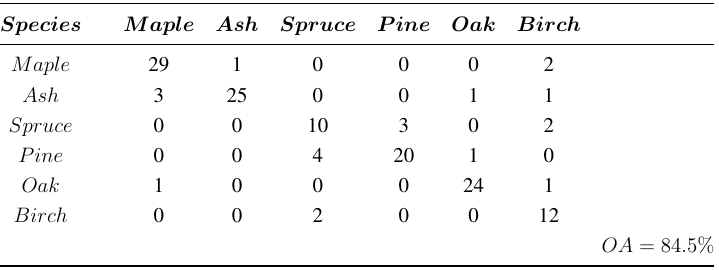
Table 1. Classification result using knowledge-based tree.